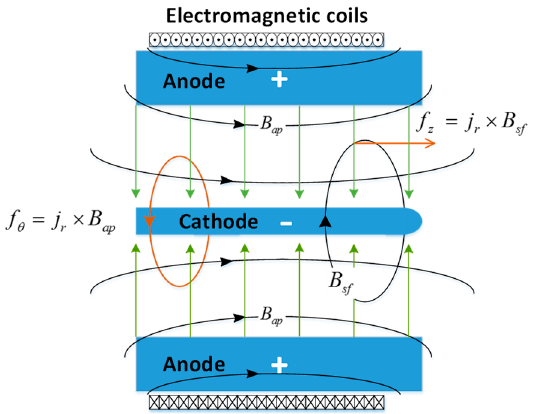
Figure 1. Magnetoplasmadynamic thruster (MPDT) schematic with applied and induced fields and currents and electromagnetic forces.